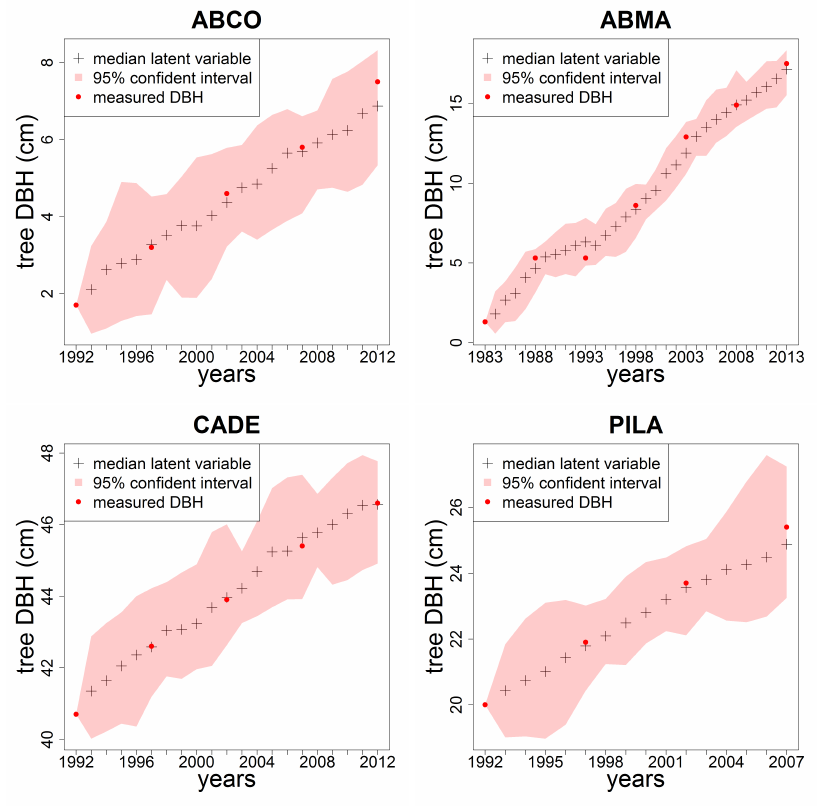
Figure 3. Latent state (tree size) is computed by the model (plotted as crosses, with uncertainty in red). Example for one tree of each of the four most common species: white fir (ABCO), red fir (ABMA), incense cedar (CADE) and sugar pine